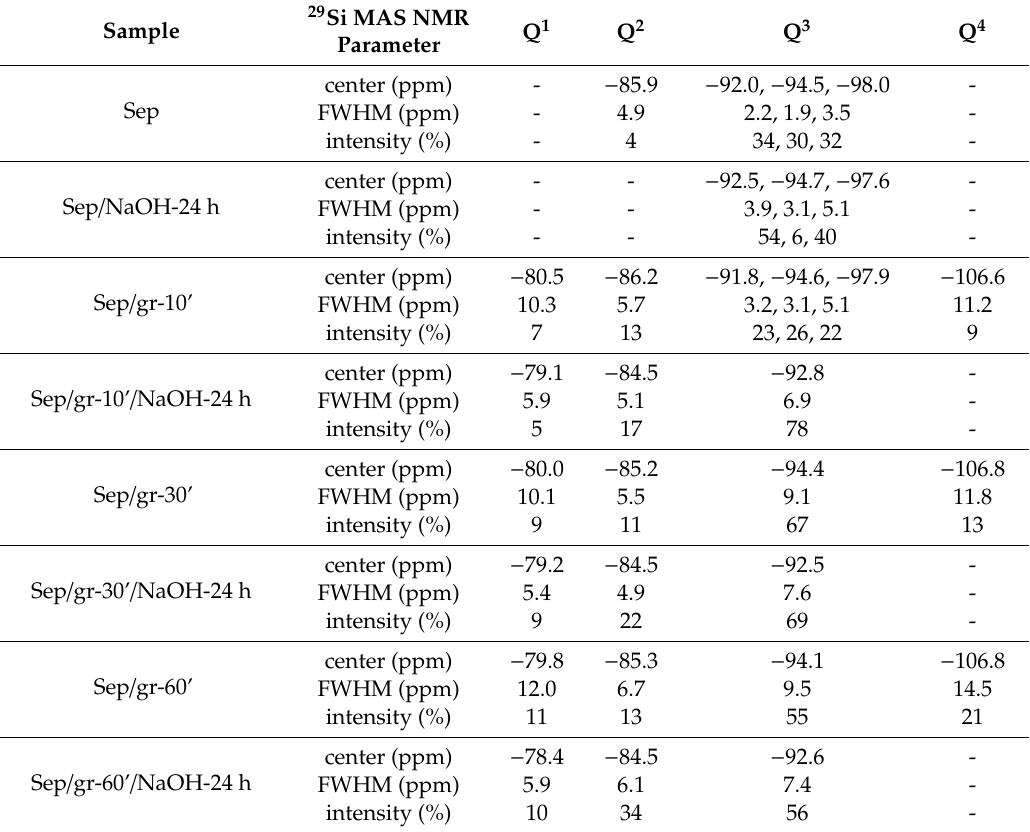
Table 2. Parameters of 29 Si MAS NMR spectra components obtained from